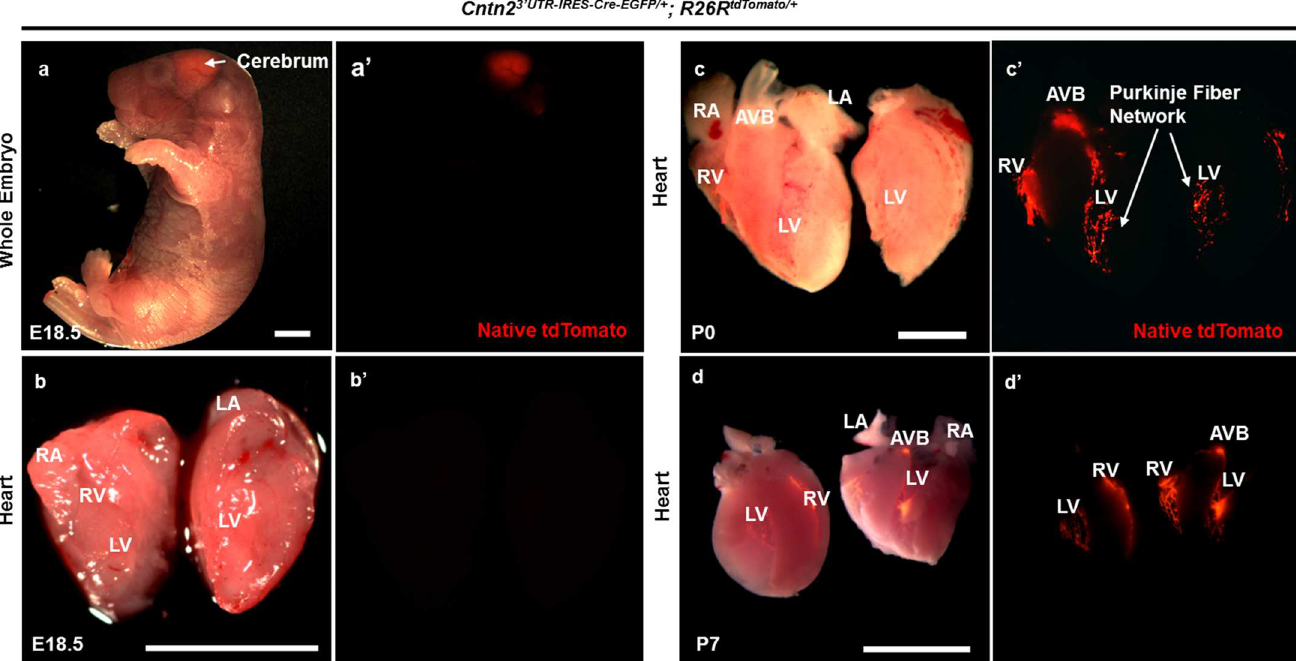
Fig 4. Cre-mediated recombination in Cntn2 3’UTR-IRES-Cre-EGFP/+ ; R26R tdTomato/+ mice is only evident after birth. (a, a’) Whole mount fluorescent image of an E18.5 doubleheterozygous embryo with robust expressionof the recombined reporter protein in the cerebrum. tdTomato expressionin the brain was also seen at E16.5 (data not shown). (b, b’) Followingmicrodissection of the heart at E18.5, native tdTomato signal was not observed. (c, c’) Double heterozygous P0 mouse heart after dissectionrevealedbright reporter protein expressionin the AVB, right and left BB, and right and left PF network. P0 was the earliest point at which reporter expressionwas observedin the heart. (d,d’) Micro-dissected P7 doubleheterozygous hearts express tdTomato protein in the identicalanatomical regionsas describedin (c,c’). The cardiac PF network appearsfully developed by P7 based on fluorescent reporter expression. At least 8 hearts were dissected per group of animalsat each time point. Scale bar: 500 μ m.